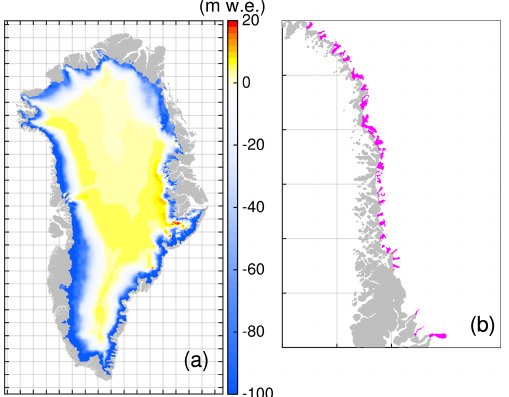
Figure 4. Atmospheric and oceanic forcing. (a) Spatial pattern of the cumulative (2015–2100) SMB anomaly based on MIROC5 RCP 8.5 and downscaled with MAR (Fettweis et al., 2020). (b) Re- treat of marine-terminating outlet glaciers in the northwestern re- gion under RCP8.5-Rhigh scenario. Purple areas indicate retreated areas in 2100. Region subsets are shown in Fig.